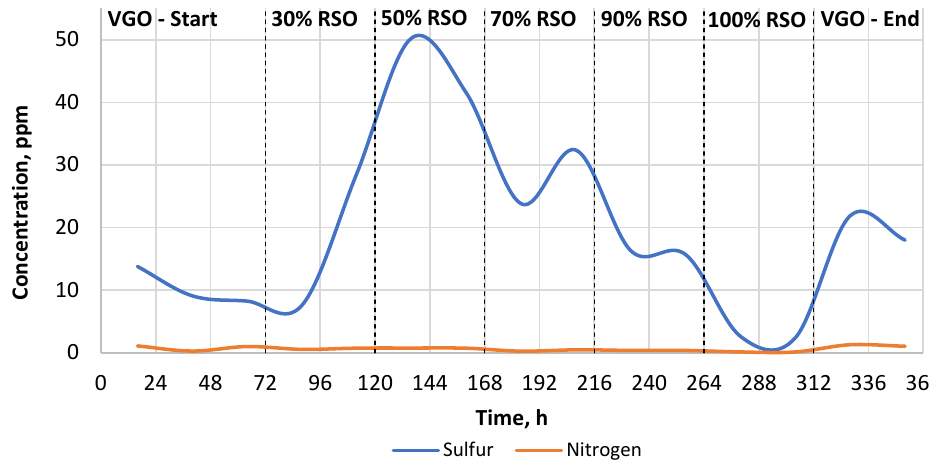
Figure 3. The change in the heteroatom content (S, N) in the liquid products throughout the experiment carried out using the NiW/Comm. catalyst